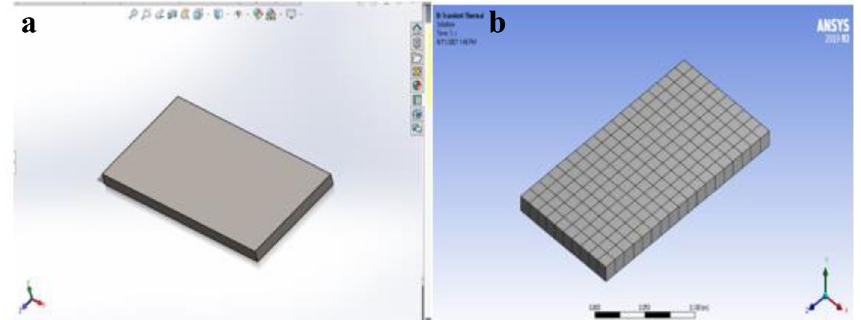
Fig. 4 a 3-d transient thermal model. b Mesh structure of the simulation